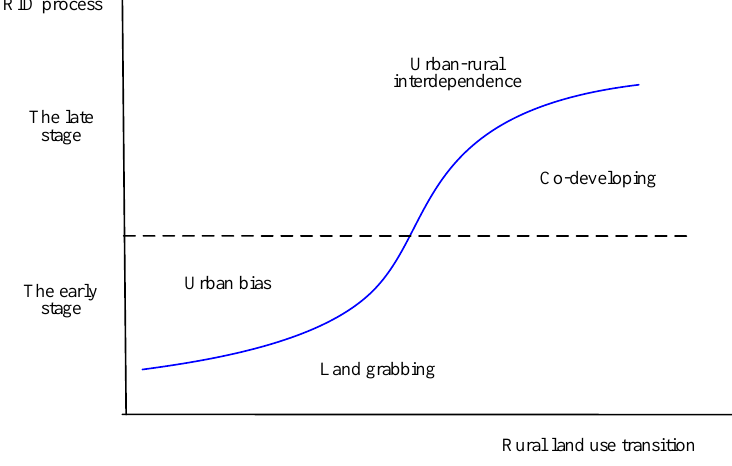
Figure 2. Dynamic process of rural land use transition and URID.